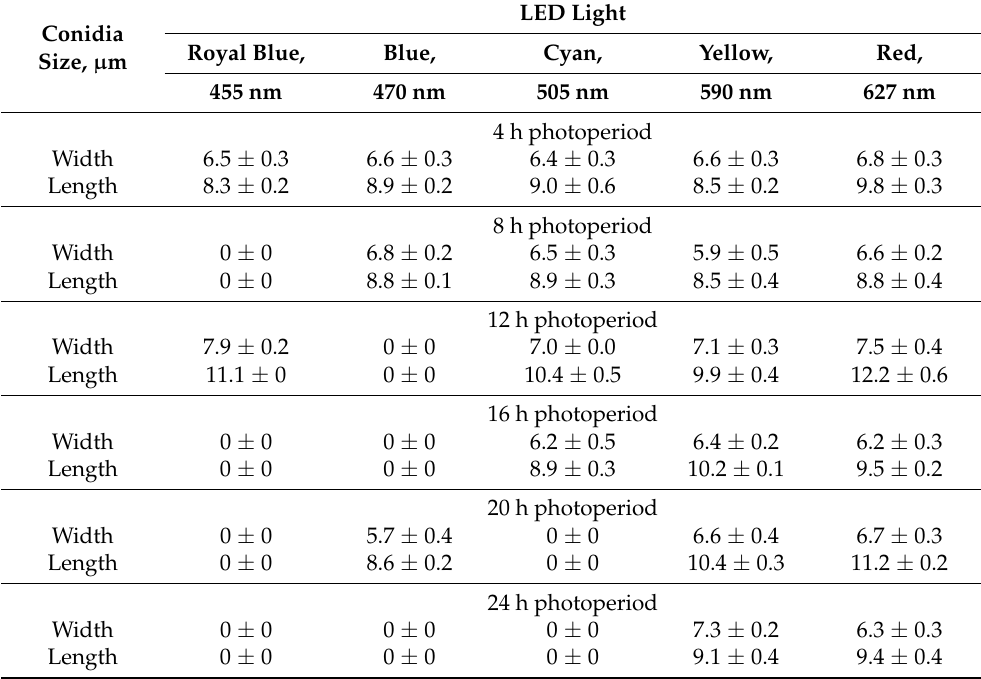
Table 2. Comparison of the average conidia size of Botrytis cinerea after illumination by various LED light wavelengths and